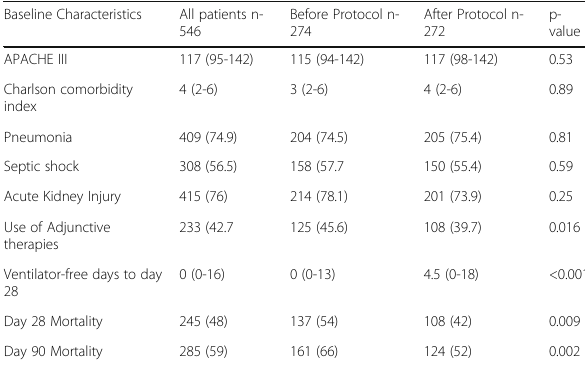
Table 1 (abstract 0002). Baseline characteristics of patients before and after the implementation of ARDS